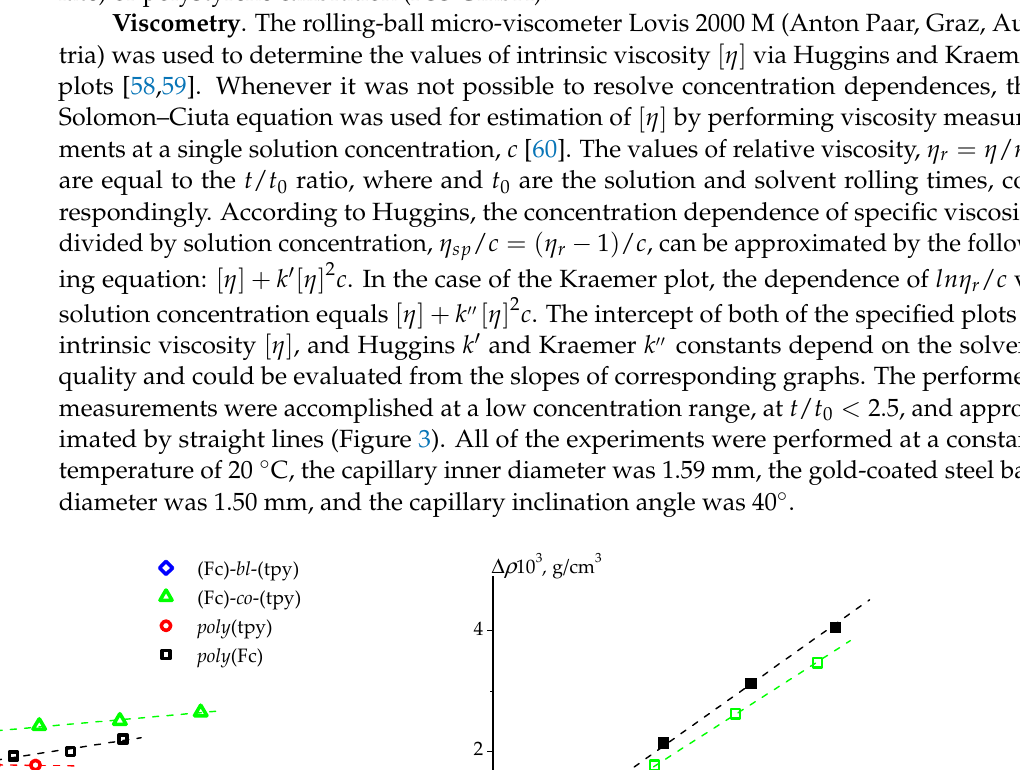
Figure 2. Normalized SEC curves of the four polymers (eluent: CHCl 3 /isopropanol/NEt 3 in a 94:2:4 volume ratio).